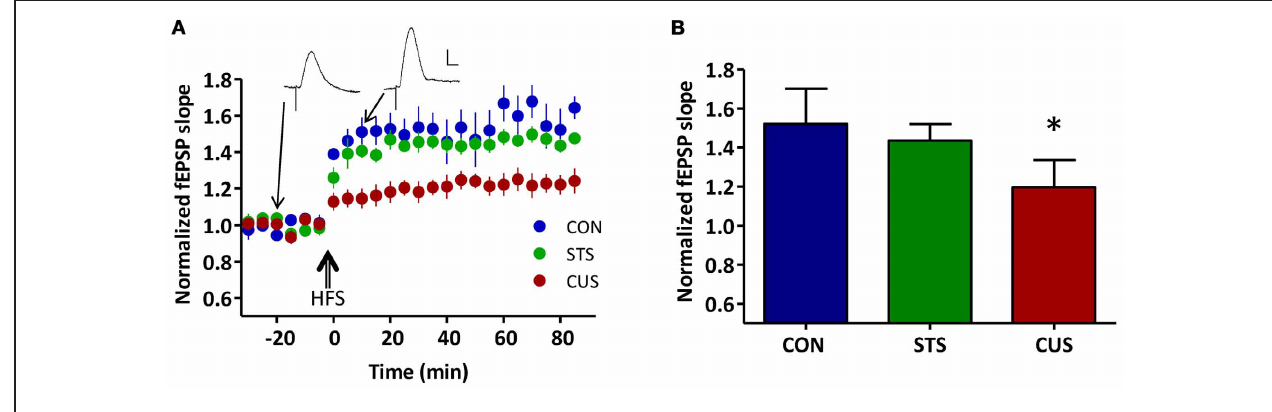
FIGURE A1 | Chronic unpredictable stress decreases synaptic plasticity between the ventral hippocampus (vHIP) and the medial prefrontal cortex (mPFC). (A) Time course of LTP induction after high frequency stimulation (HFS); each circle represents the average of 10 normalized fEPSP slopes with SEM; three groups are depicted: controls